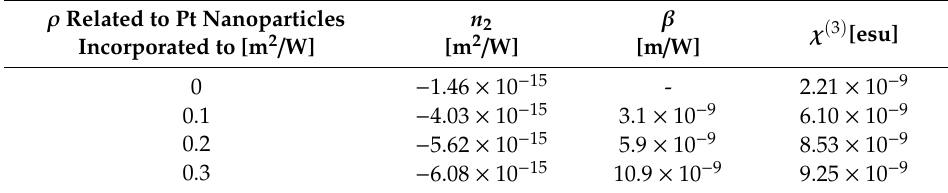
Table 1. Nonlinear optical parameters evaluated in nanohybrids studied at a 532 nm and 4 ns pulses. Table 2. Nonlinear optical parameters evaluated in the samples studied at 532 nm and 4 ns pulses. ρ Related to Pt Nanoparticles Sample Incidence Incorporated to [m 2 / W]